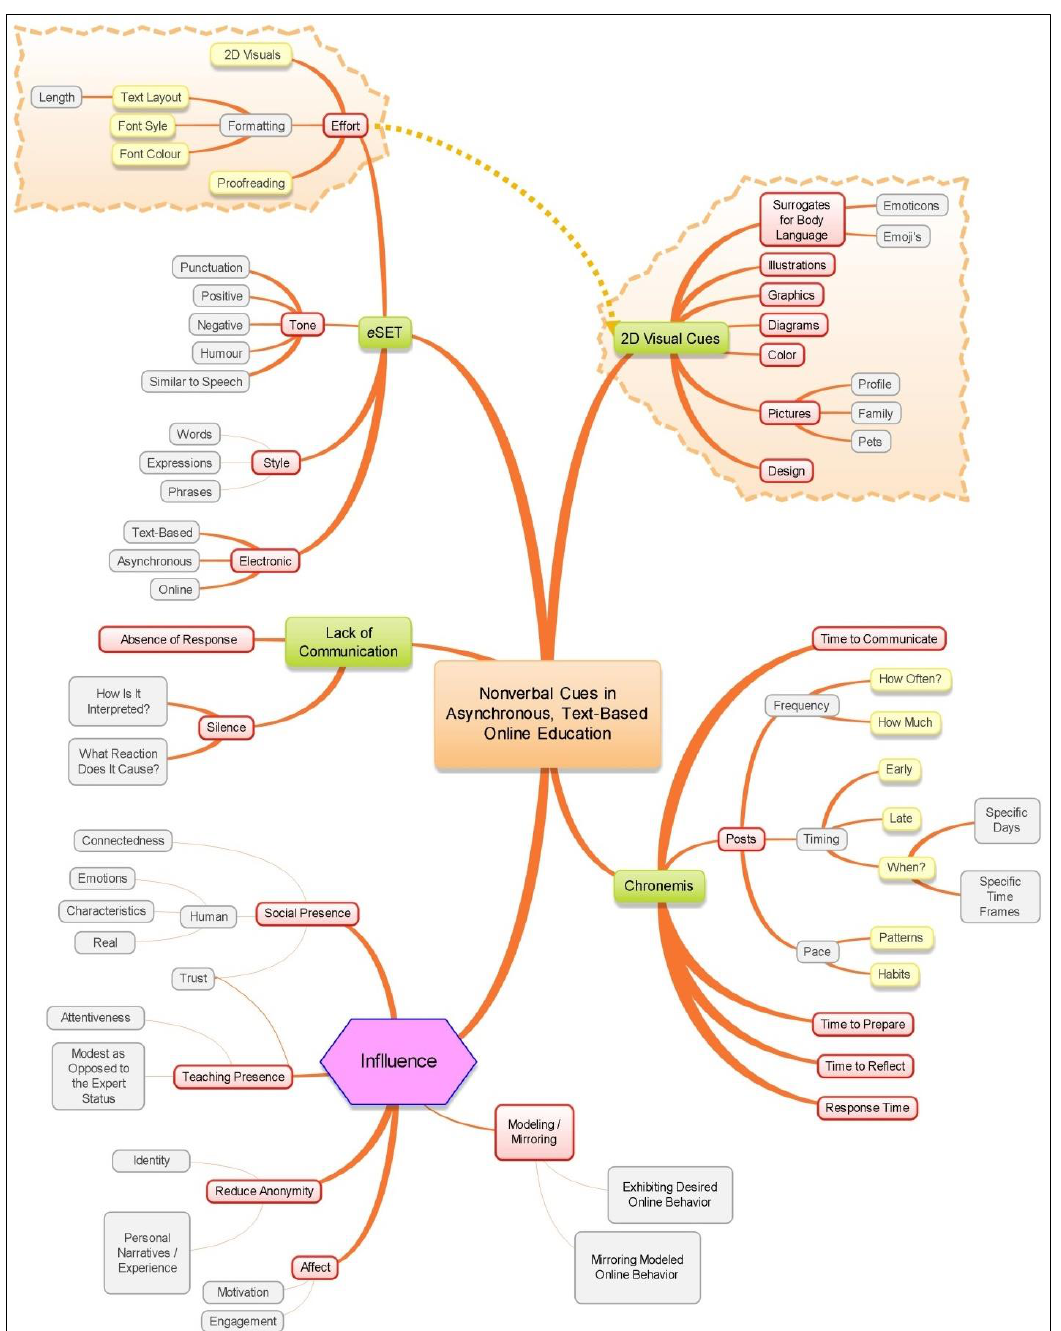
Figure 2 . Mind map illustrating phase 1 findings and e NVC